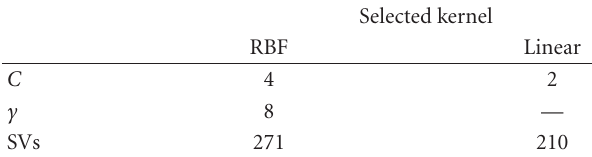
Table 1: Comparison of SVM models.